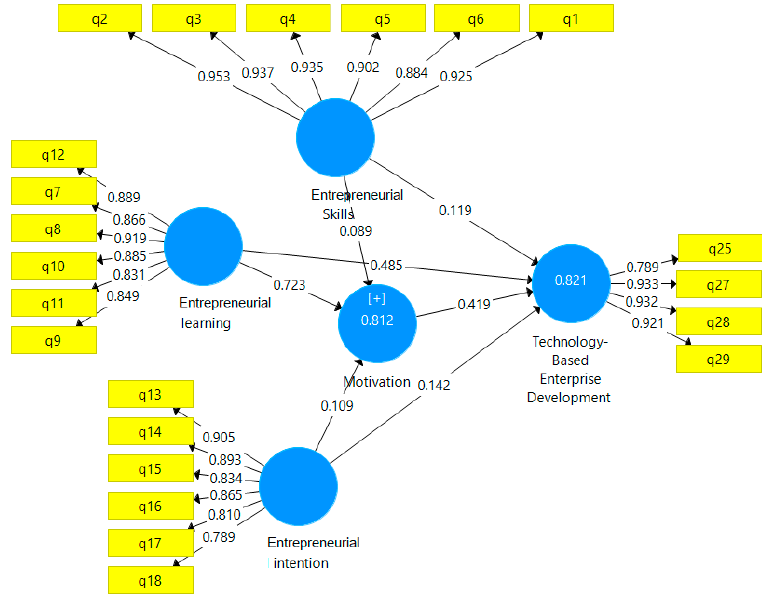
Figure 3. Standard factor loadings and R 2.